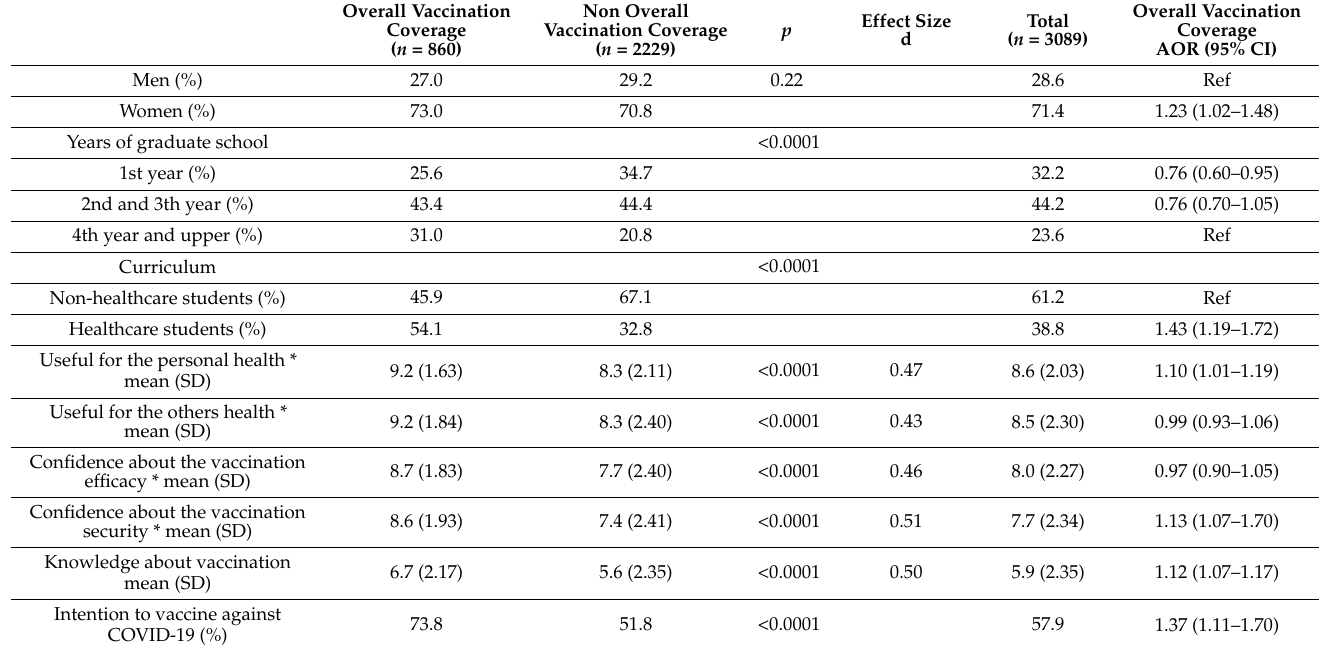
Table 1. Overall vaccination coverage and associated factors among university students (France) n =